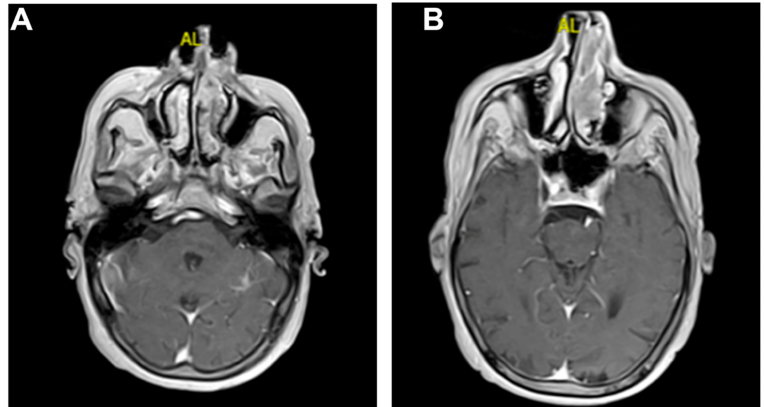
Figure 2. MRI (axial plane): ( A , B ) after administration of gadolinium, no significant signal enhance- ment was recorded, with the exception of a minimal phlogistic thickening of the parietal mucosa in the left ethmoidal sinus.